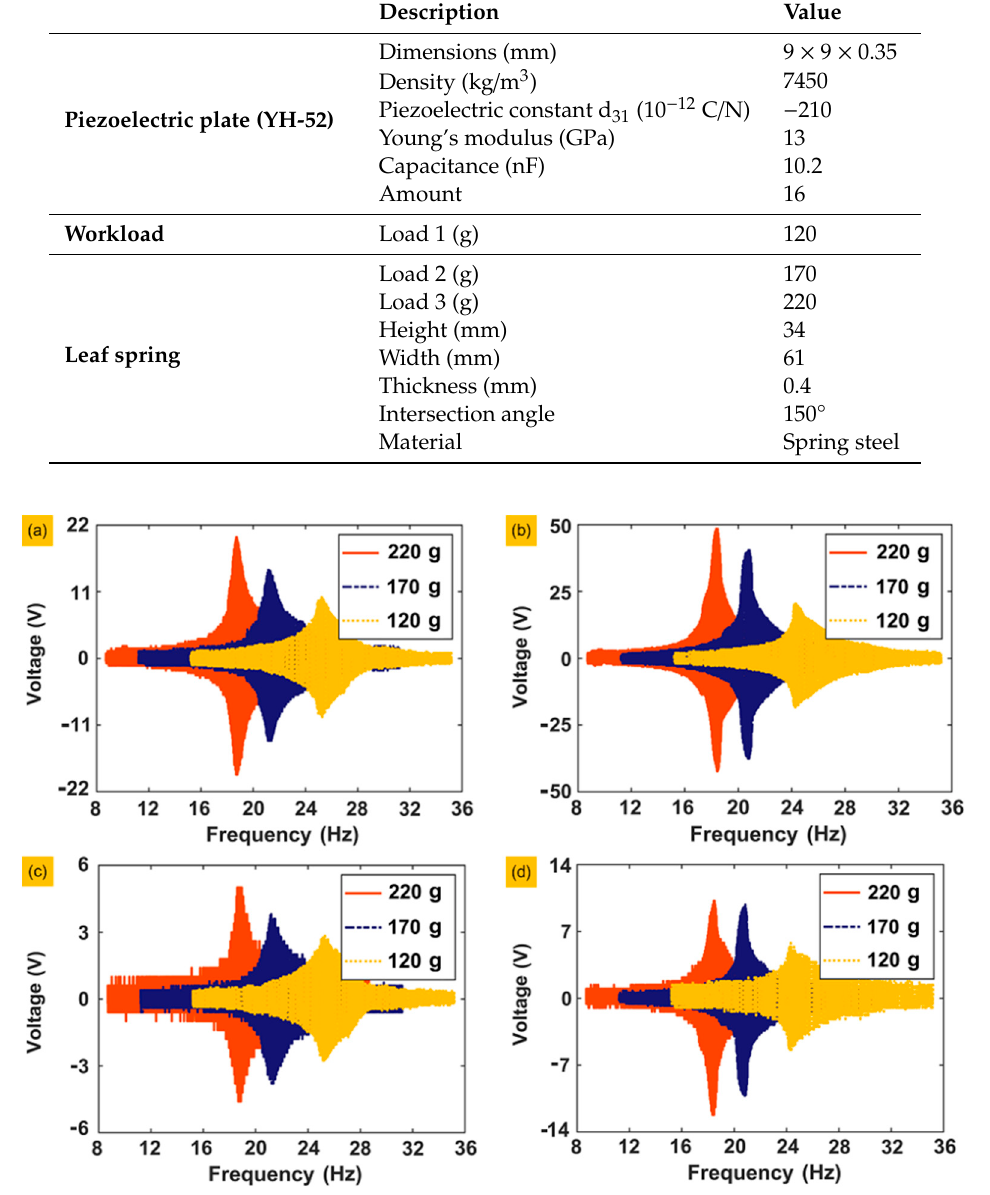
Table 1. Material properties and prototype parameters.